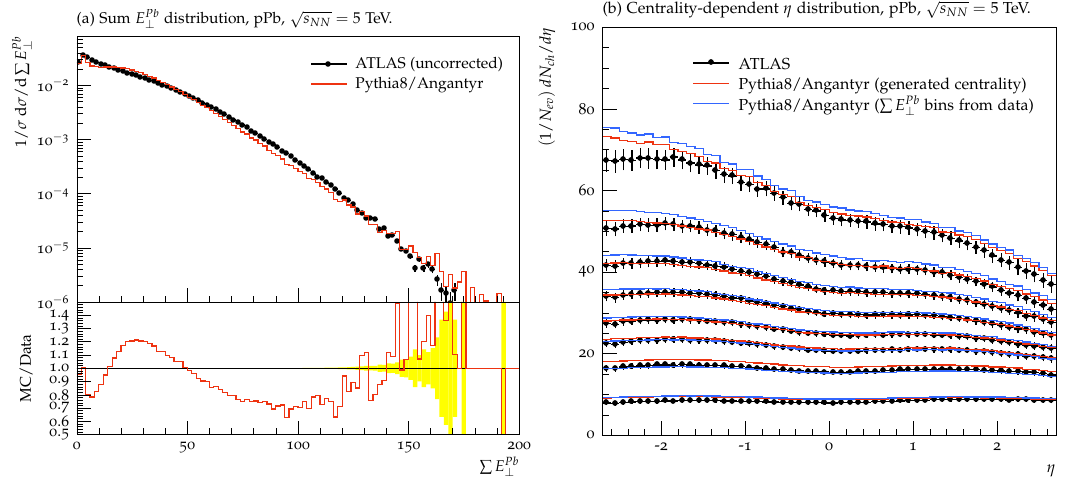
Figure 1. ( a ) ∑ E Pb distribution of generated pPb events at √ s NN = 5 TeV. ( b ) Charged multiplicity distribution of ⊥ pPb collisions at √ s NN = 5 TeV from ATLAS [13] compared with the Angantyr generated events with two different means of centrality